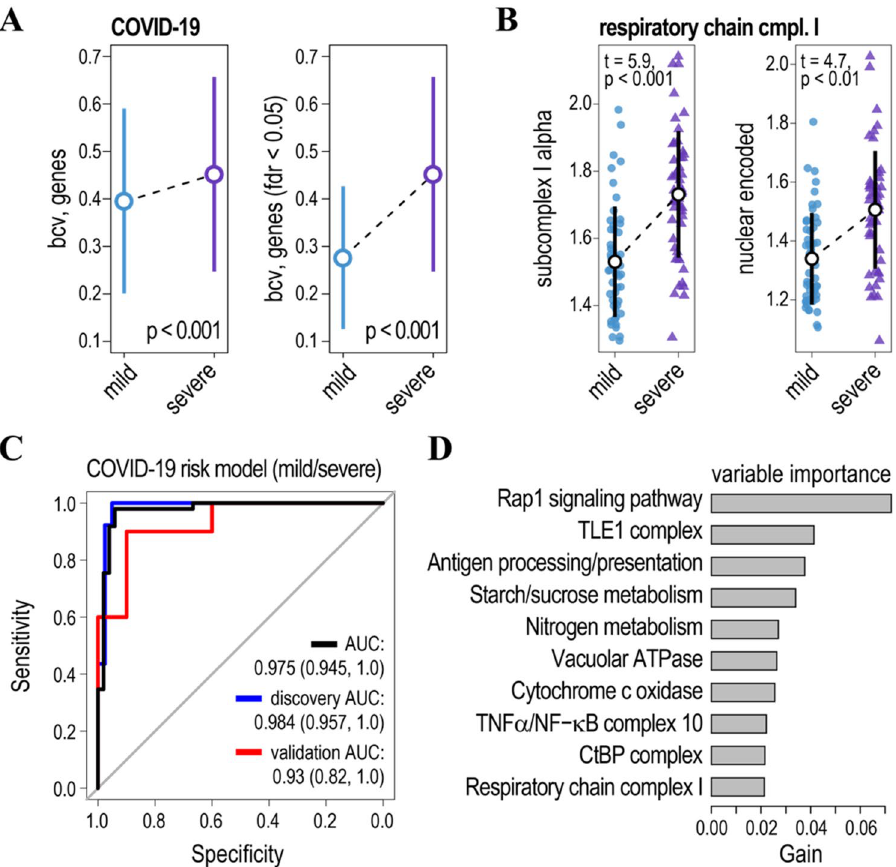
Figure 6. Association of gene ensemble noise with the COVID-19 disease state. ( A ) Inter-individual biological variability in leukocyte gene expression (bcv—biological coefficient of variation) increases in severe COVID- 19 patients as compared to the mild ones. Left panel—average estimates of the bcv for all genes expressed in the patients’ leukocytes, right panel—bcv for the genes with significant changes in inter-individual biological variability (false discovery rate, FDR < 0.05). p -values of t-tests comparing differences in inter-individual gene expression variability for mild and severe COVID-19 patients. Circles and whiskers indicate means and standard deviations respectively. ( B ) Plots of gene ensemble noise for genes encoding subunits of mitochondrial respiratory chain complex I (subcomplex I alpha—left panel and nuclear-encoded subunits—right panel). Black circles and whiskers indicate means and standard deviations. t and p -values of the tests comparing gene ensemble noise for mild and severe COVID-19 patients are shown. ( C ) ROC curves for the model based on the gene ensemble noise for the discovery (blue line) and validation (red line) cohorts, and all samples (black line). For further details on the model accuracy see Tables 2 and S4. ( D ) Relative contribution of gene ensemble noise features to the model. For further details see Table